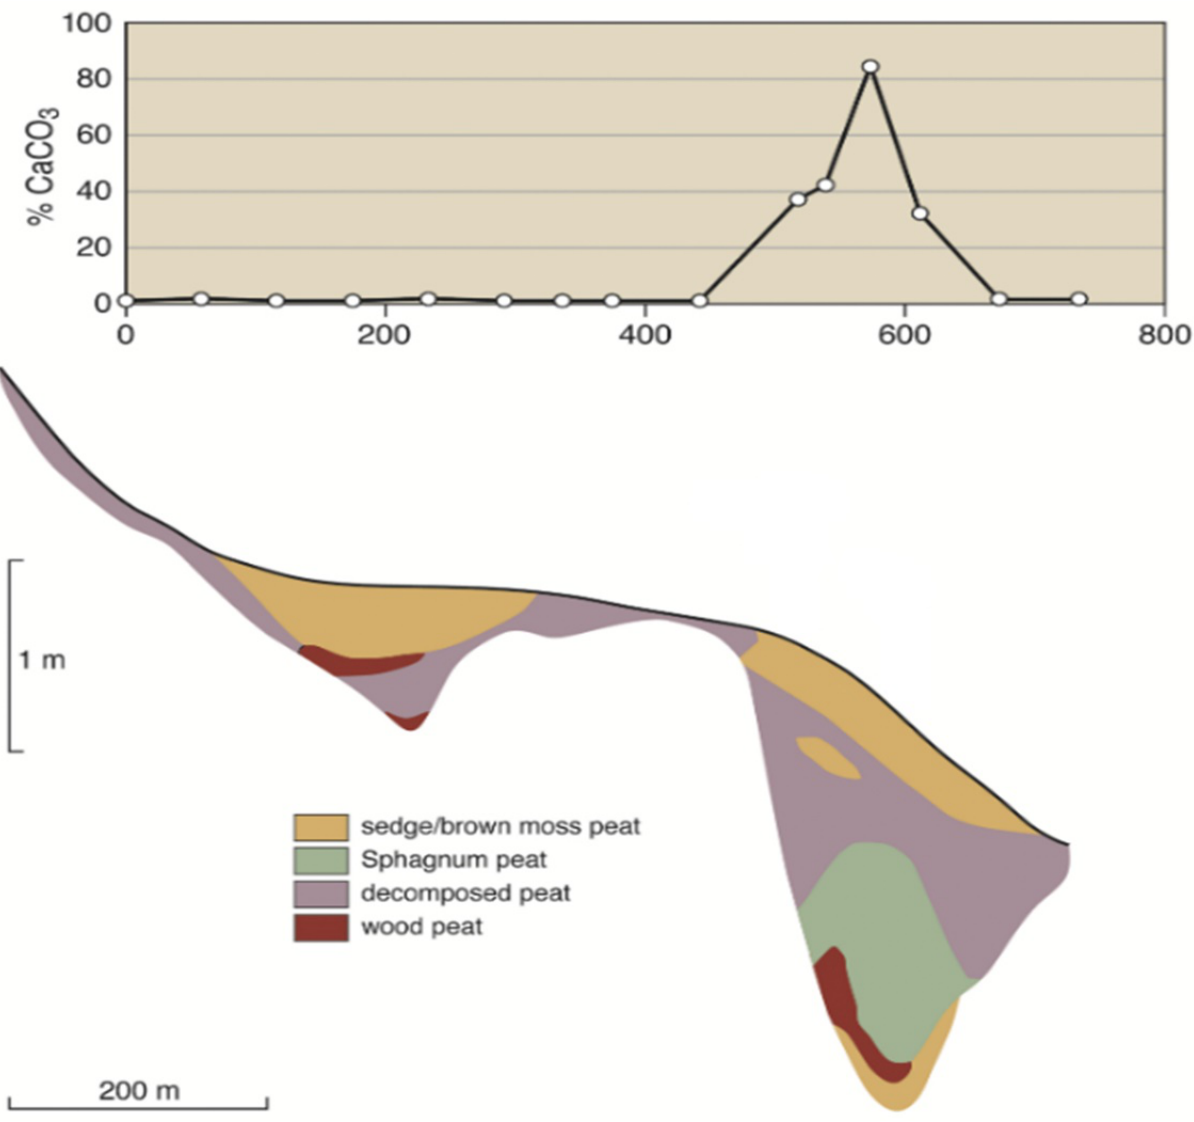
Figure 6: Peat development of Belianske Lúky in Slovakia. The spring fen complex started as an alder wood, then it became a mixed mire (dominated by Sphagnum fuscum ), dried out, returned to being an alder forest for 3000 years, and finally became an alkaline fen ca. 600 years cal BP (after Hájková et al .